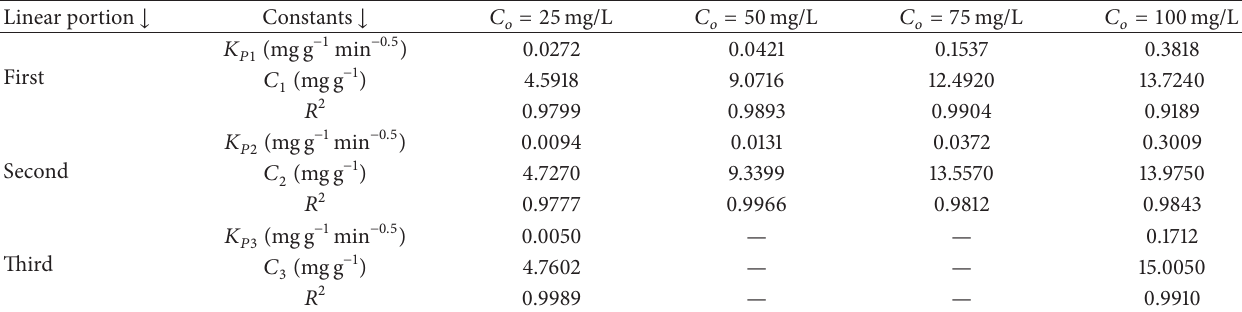
Table 3: Intraparticle diffusion constants for different initial AB25 concentrations at 30 ∘ C. Conditions as in Table